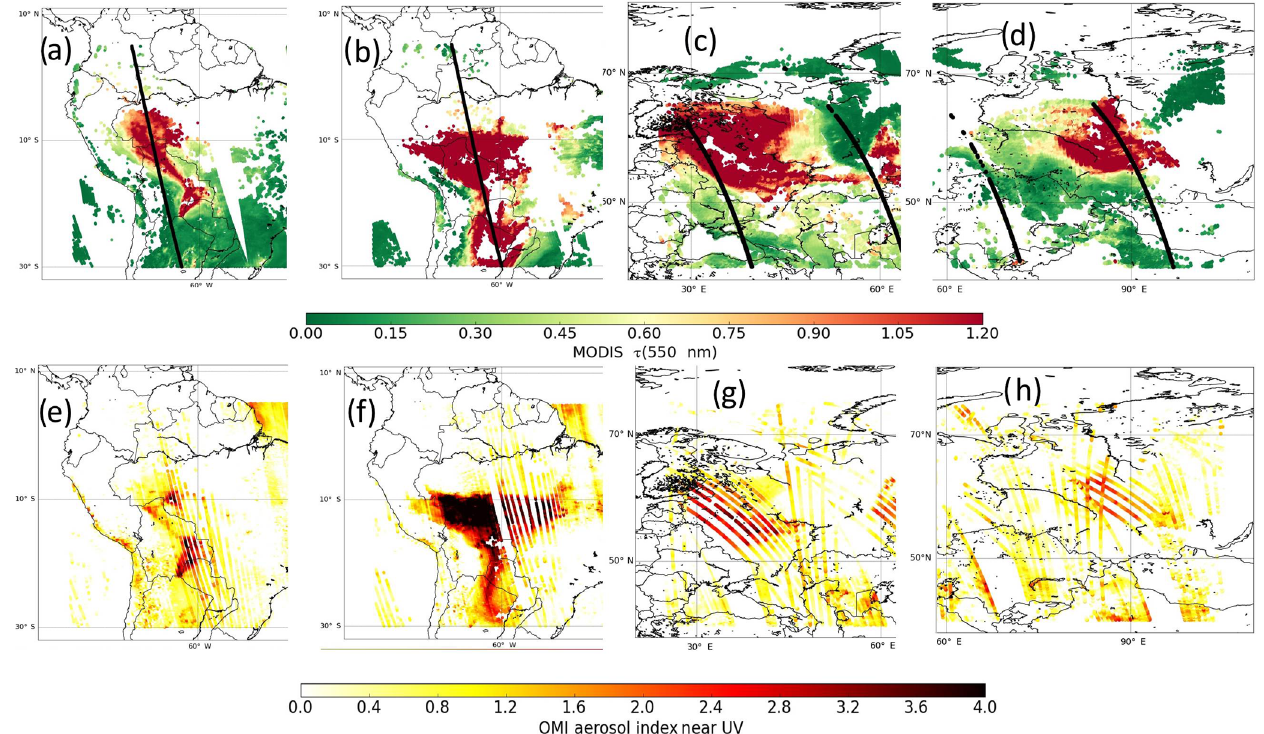
Figure 6. Maps of Aqua MODIS τ( 550nm ) from the combined DT and DB Collection 6 (see Sect. 2.4) and collocated OMI aerosol index from near-UV (UVAI) values (see Sect. 3) over cloud-free scenes and intensive biomass burning episodes. The dark thick lines represent the track of CALIPSO space-borne sensor over the selected case studies: (a, e) South America on 24 August 2006, (b, f) South America on 30 September 2007, (c, g) eastern Russia on 8 October 2010, and (d, h) eastern Russia on 23 June